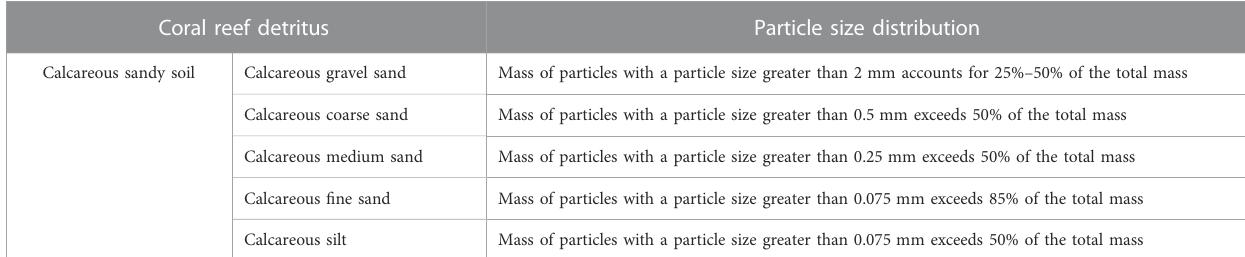
TABLE 1 Classi fi cation of coral reef debris. Coral reef